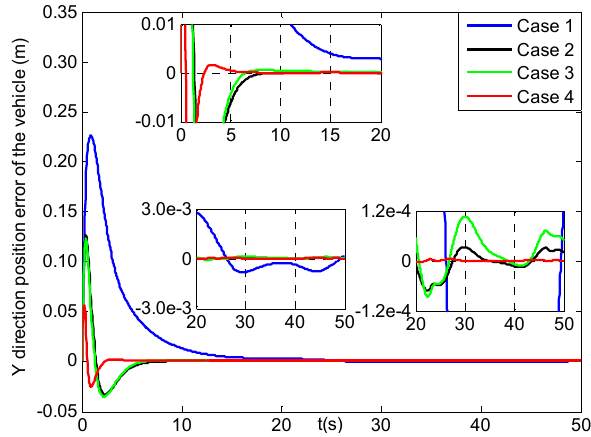
Figure 23. Y direction position errors of the vehicle (four cases).